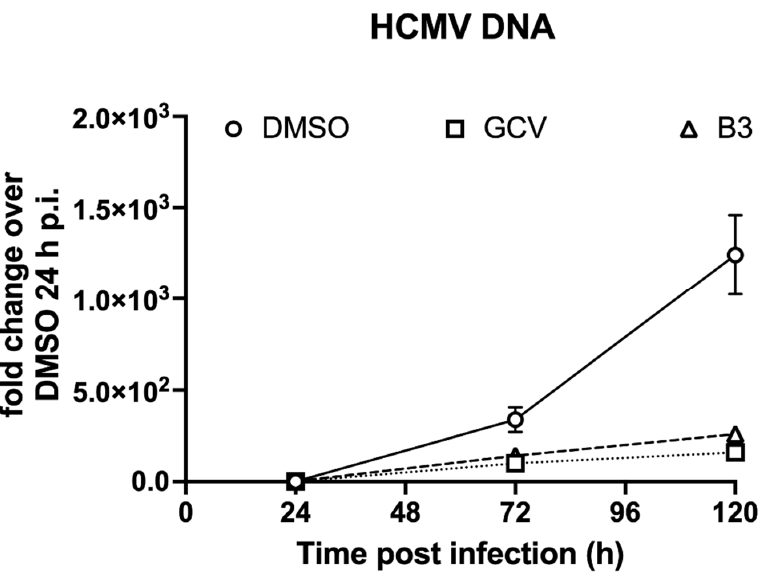
Figure 8. B3 impairs HCMV genome replication. MRC5 cells were infected with HCMV TB4-UL83-EYFP and treated with the indicated compounds or vehicle alone (DMSO) as described in the Materials and Methods section. At the indicated time points p.i., cells were lysed and processed for qPCR to detect the presence of viral and host cell genomic DNAs as described in the Materials and Methods section. Data are shown as HCMV DNA fold changes with respect to DMSO-treated cells at 24 h p.i. Means ± standard deviation of the mean from two independent experiments performed in quadruplicate are reported.